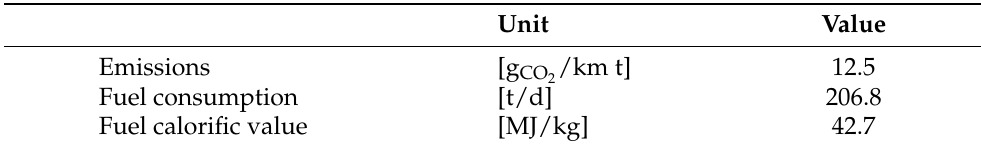
Table 3. Impact evaluation data of a HFO powered MAN S90ME-C9.2-GI cargo ship considering